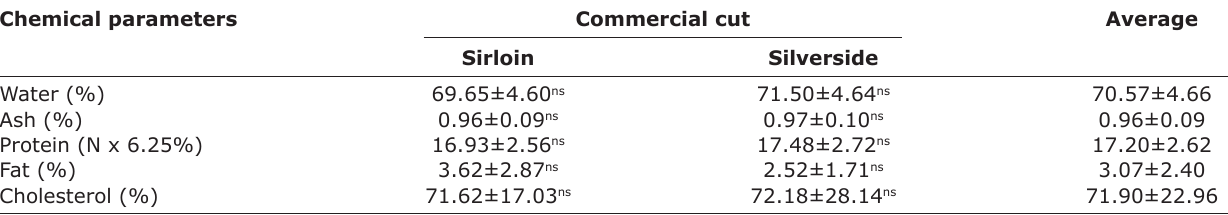
Table-2: Meat chemical parameters (±SD) of two commercial cuts of Aceh cattle. Chemical parameters